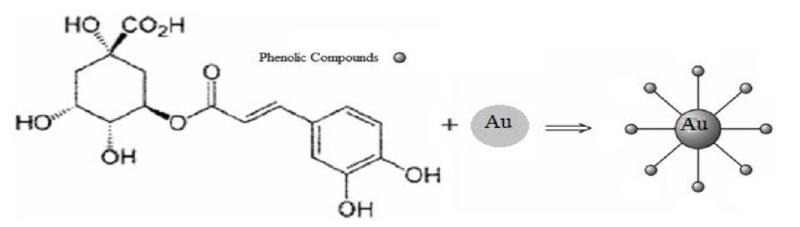
Fig. 1. Schematic formation of Au Nanoparticle.